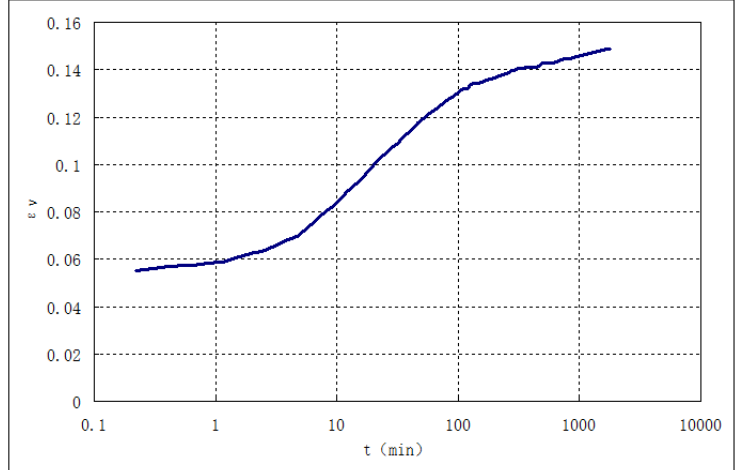
Figure 5. The relationship graph between the clay strain value and the time